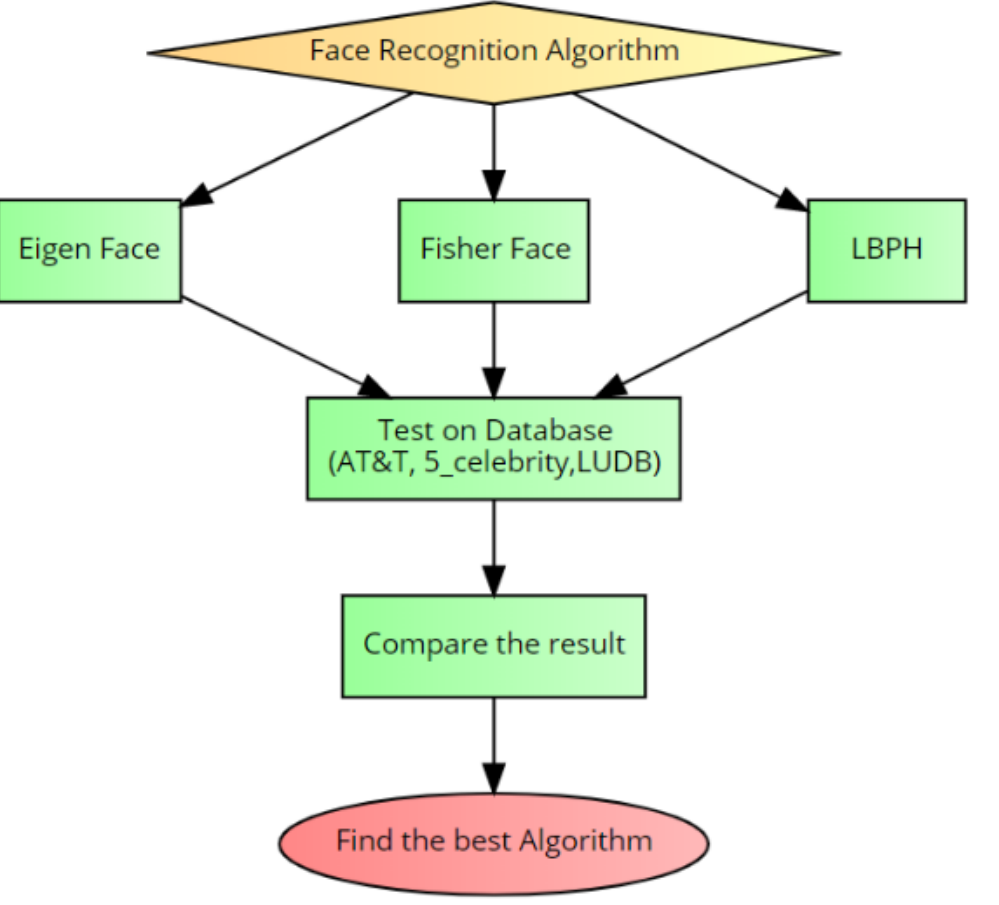
Figure 2. Flow chart of the Facial recognition experiment used in this